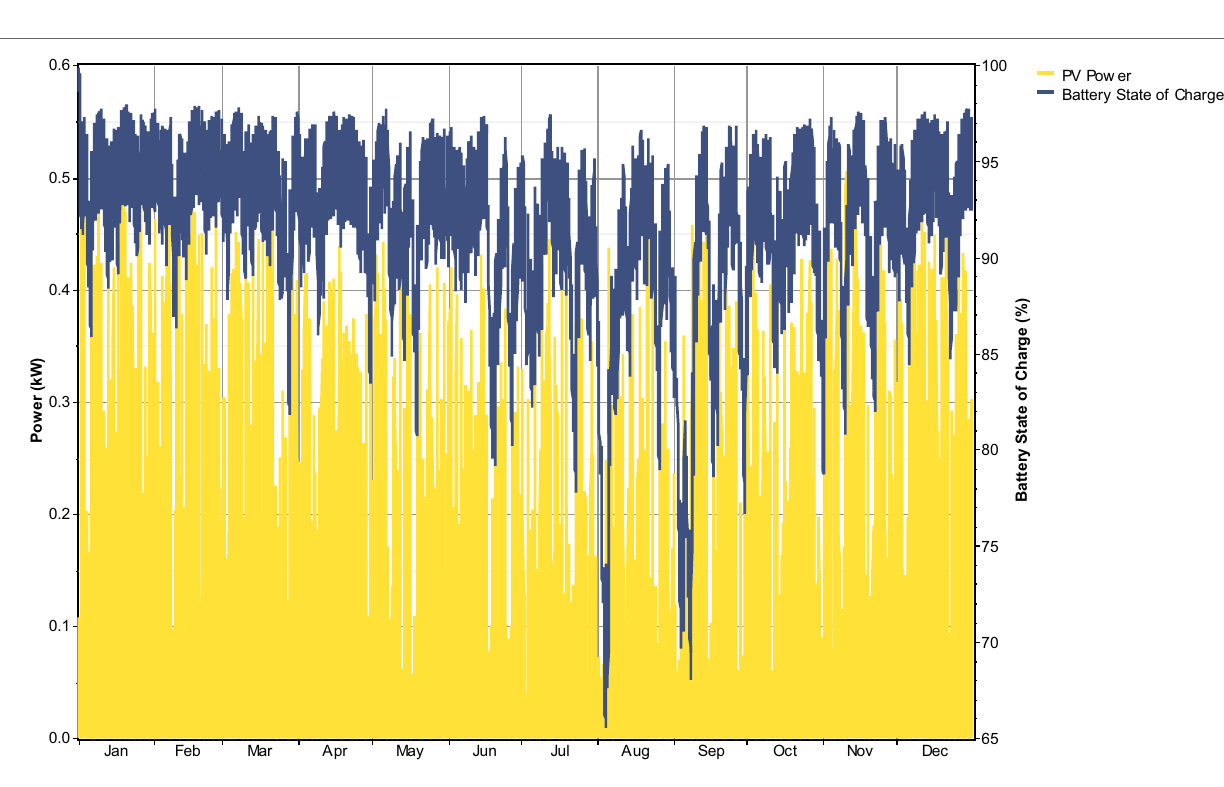
FigUre 8 | PV power versus Battery state of charge